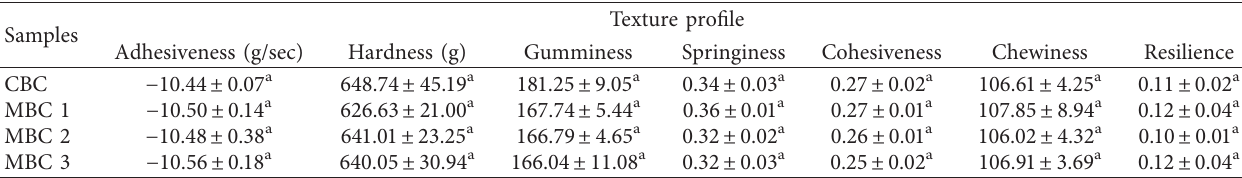
Table 6: Texture profile of broiler chicken meat obtained from a genuine supplier and three different markets.